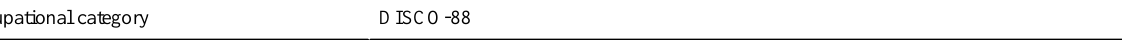
Holtermann’s group (occupations that are strongly associated with heavy lifting)